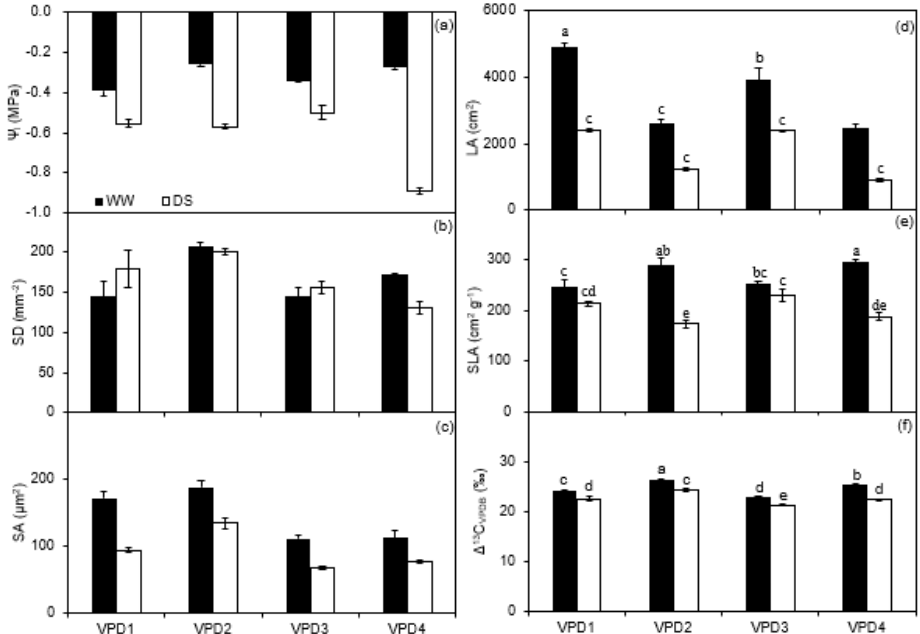
Figure 4. Leaf water potential ( ψ l ; ( a )), stomatal density ( SD ; ( b )), stomatal pore aperture ( SA ; ( c )), leaf area ( LA ; ( d )), specific leaf area ( SLA ; ( e )), and leaf carbon isotope ( Δ 13 C ; ( f )) of well-watered (WW) and drought-stressed (DS) potato plants grown under different vapor pressure deficits in the greenhouse cells at final harvest. Error bars indicate the standard error of the mean ( n = 3). Plant water relations data throughout the growth period can be seen in Figure S2 in the Supplementary material. Different small letters indicate significant difference at p < 0.05 level.